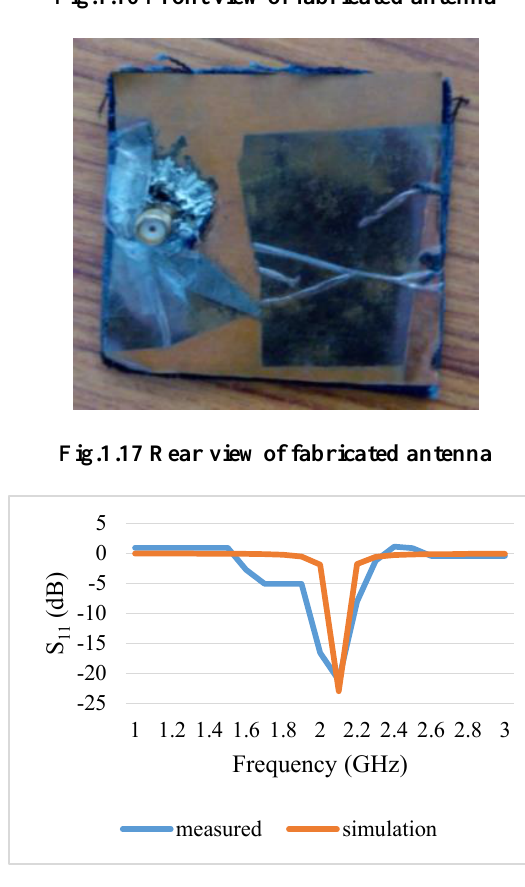
Fig.1.18. S 11 Response of measured and simulated results of Antenna